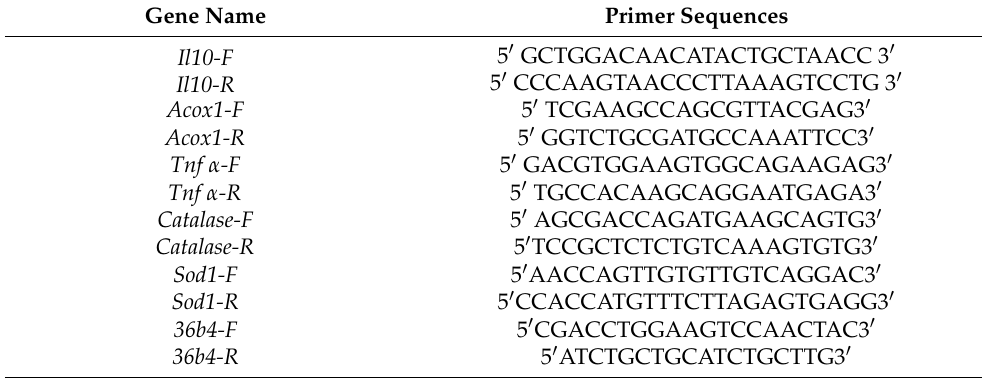
Table 2. Sequences of the primers used for